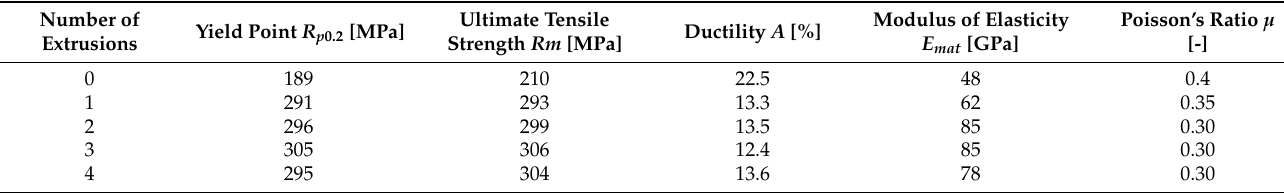
Table 2. Results of mechanical properties.